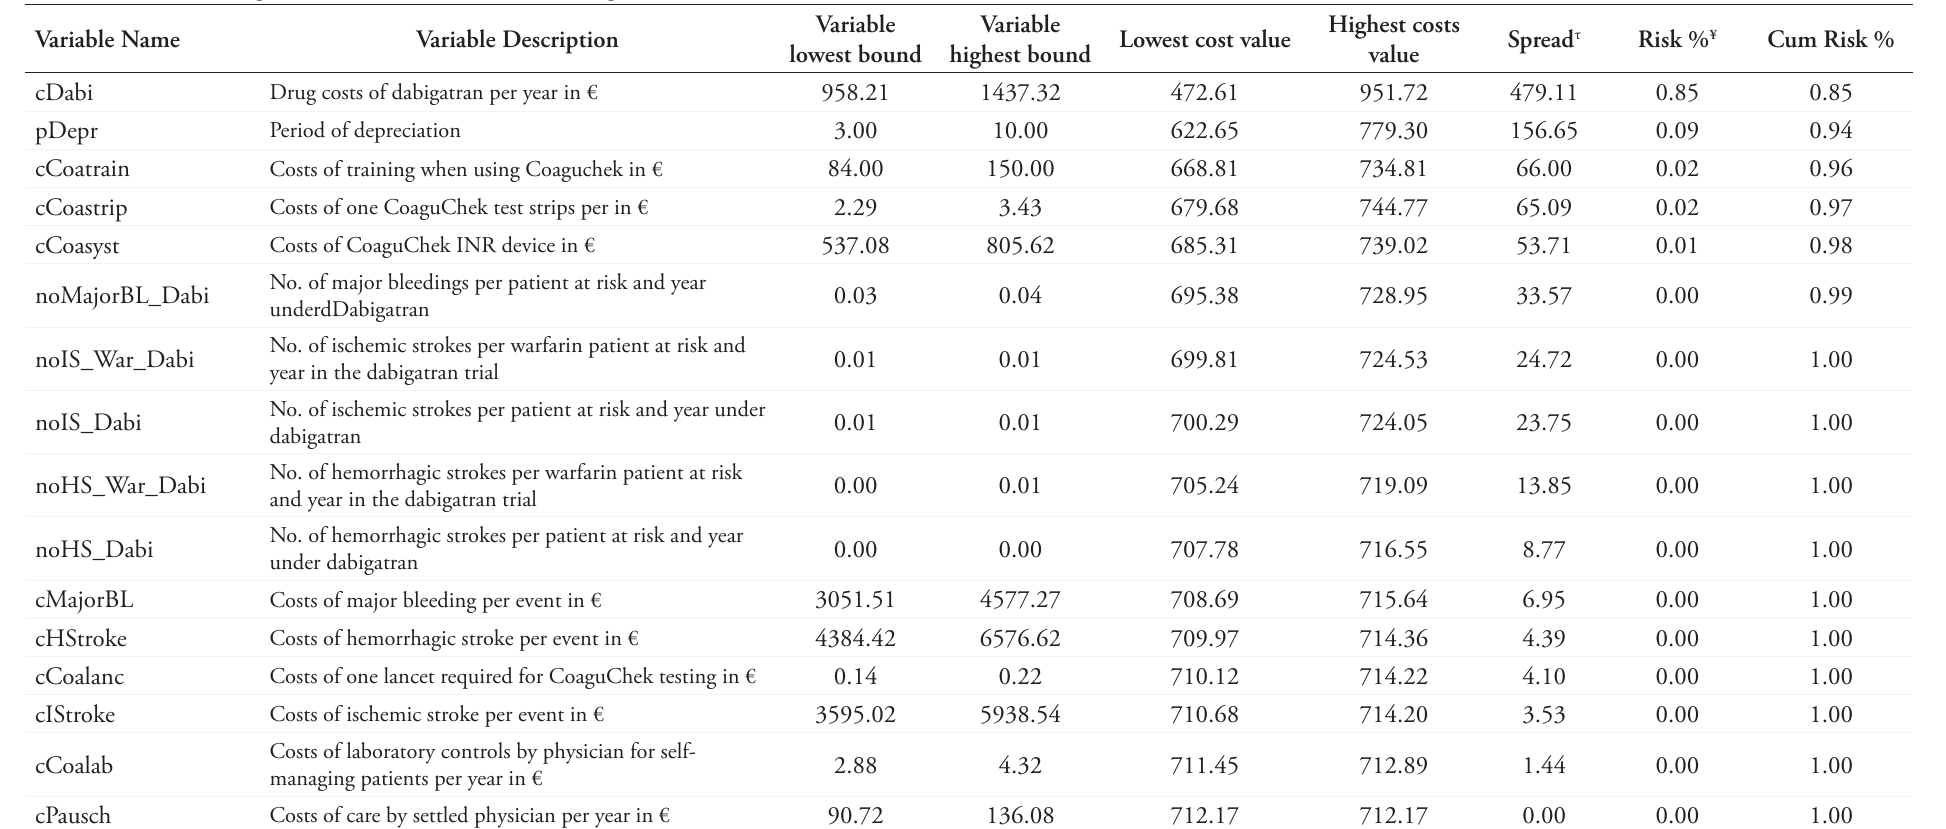
Table 5b: Tornado diagram*: VKA under PST versus